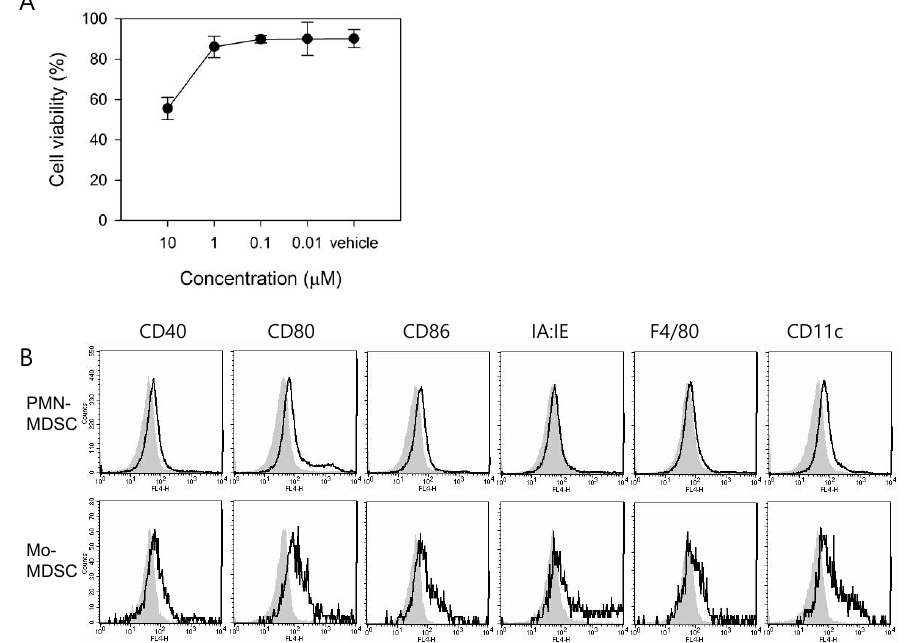
Figure 2. In vitro treatment with ATX induces MDSC di ff erentiation. ( A ) MDSCs were isolated from spleens of CT-26 tumor-bearing mice, and the cells incubated for 24 h in the presence of ATX and LPS. Cell viability was measured by the thiazolyl blue tetrazolium bromide (MTT) assay. Data are shown as means ± SEM. Data are representative of two experiments. ( B ) MDSCs were isolated from tumor-bearing mice and cultured for 5 days with 10 ng / mL of GM-CSF. ATX or veh was added on days 0 and 3. After treatment, cells were harvested and stained with fluorescent-labeled Abs. The levels of surface markers, such as CD40, CD80, CD86, IA:IE, F4 / 80, and CD11c were measured on each MDSC subset. Data show veh-treated (filled areas) and ATX-treated (bold lines) cells. Data are representative of three